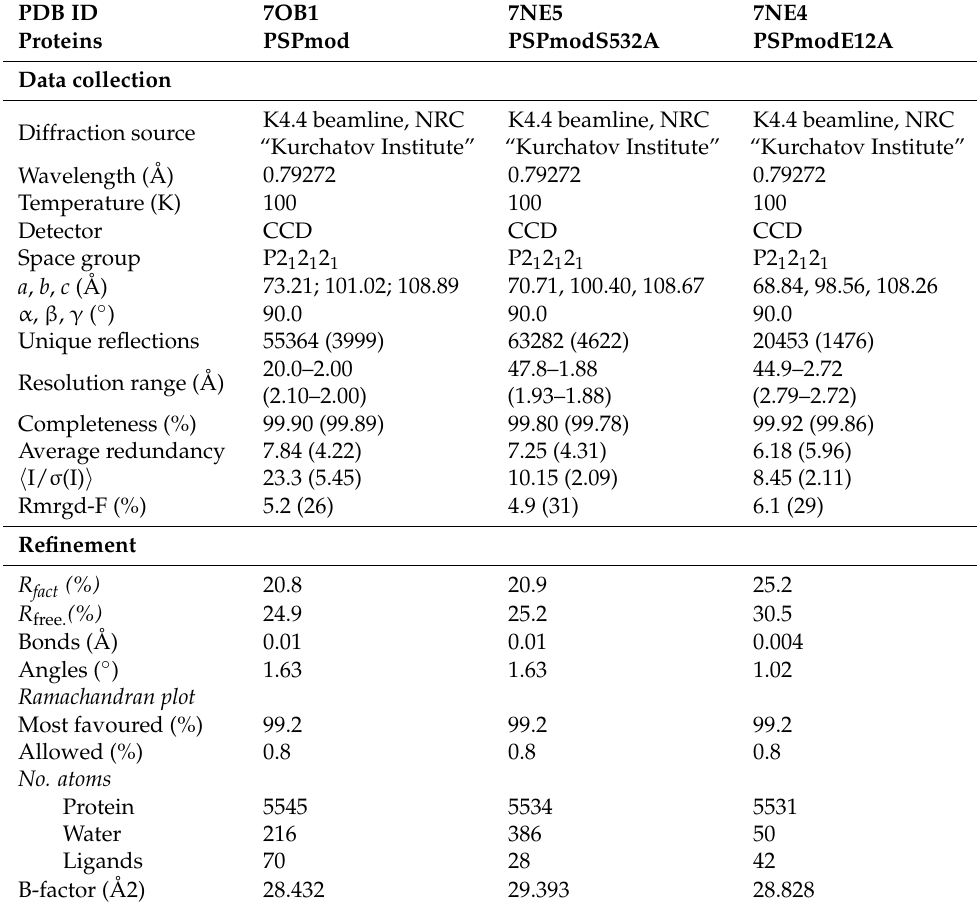
Table 1. Data collection, processing, and